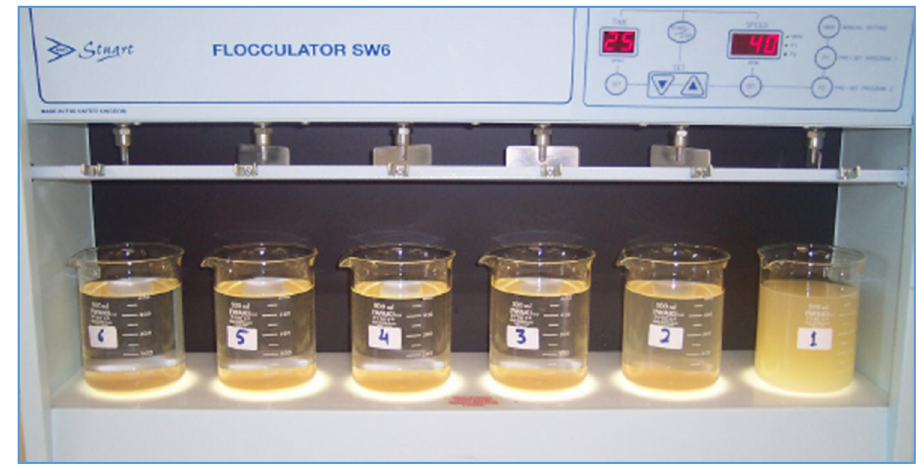
Figure 2: Jar test